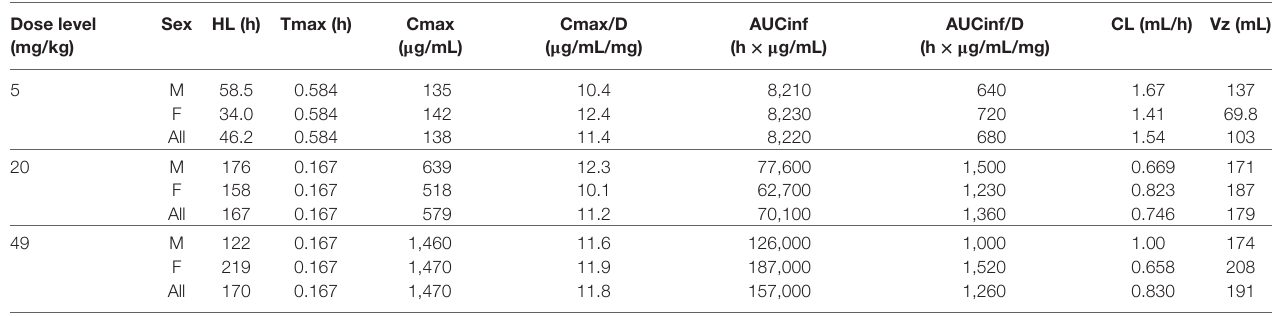
Eight male and eight female animals (two animals/sex/group) were injected intravenously with 0 (saline solution), 5, 20, or 49 mg/kg of NEO-201. Blood samples were drawn in all animals that received NEO-201 at various time points (pre-dose, 10 min, 1, 2, 4, 6, 24, 48, 72, 96, 168, and 336 h post-dose), and pharmacokinetic measurements from serum preparations were obtained by ELISA. Values in the table represent the average from the two animals/sex/group (M, F) or from all four animals (All). AUCinf, area under plasma concentration–time curve from time 0 to infinity; AUCinf/D, dose-normalized area under the plasma concentration–time curve from time 0 to infinity; CL, clearance; Cmax, maximum observed plasma concentration; Cmax/D, dose-normalized measured maximum plasma concentration; HL, half-life; Tmax, time of maximum observed plasma concentration; Vz, volume of distribution.